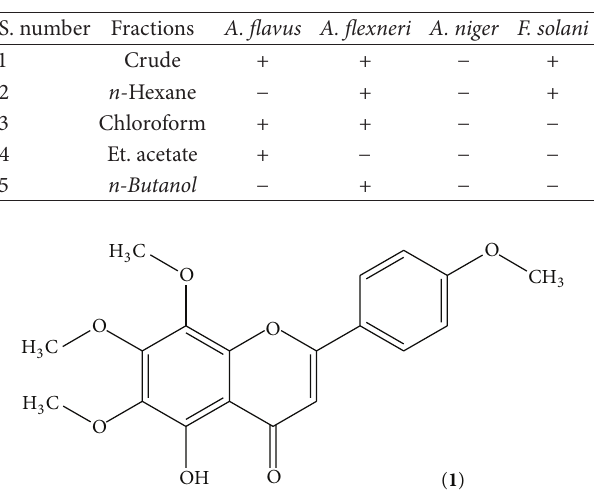
(14 mm), while, in our present investigation, the whole plant ( O. corniculata ) crude extract, its solvent soluble